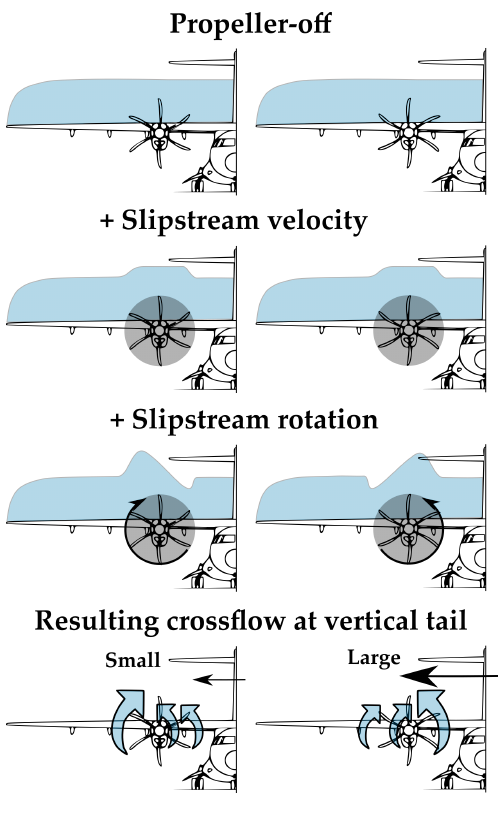
Figure 4. Effects of propeller slipstream on vertical tail due to the wing loading distributions caused by inboard-up and outboard-up